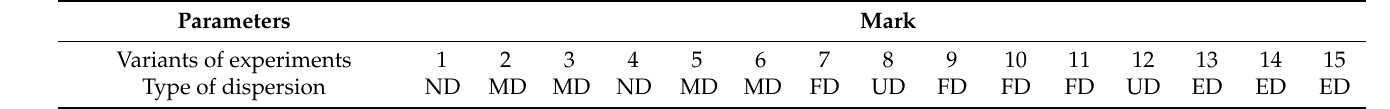
Figure 5. Typical types of inert gas dispersion in liquid aluminium formed during the refining operation: ( a ) no dispersion (geyser and single bubbles creation), ( b ) minimal dispersion, ( c ) fine dispersion, ( d ) uniform dispersion, ( e ) excessive dispersion (chain flow and swirls). Table 3. Summary of visualization results—different types of gas-bubble dispersion. Mark